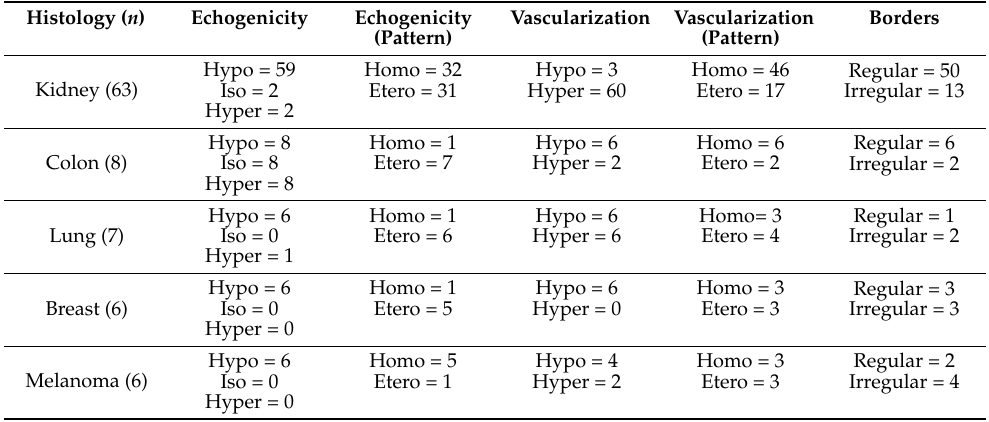
Table 2. EUS features per histology type. Less than 3 patients with fibro-leiomyosarcoma, ovarian cancer, liver and thyroid cancer, Merkel cell tumor and non-Hodgkin lymphoma underwent